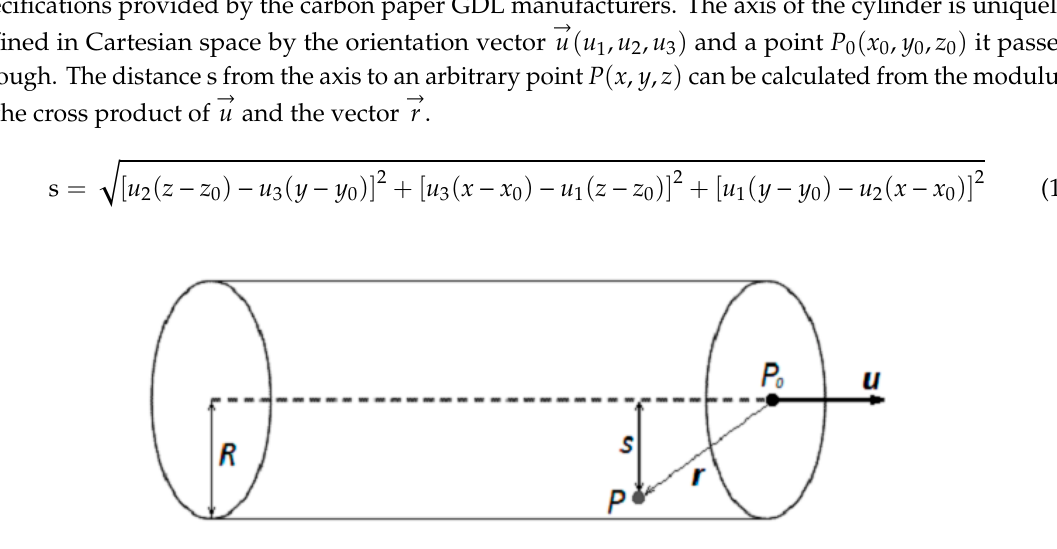
Figure 5. Cylindrical model of the fibers.